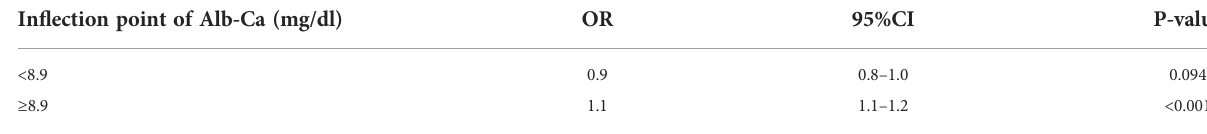
TABLE 1 Threshold effect analysis of albumin-corrected calcium and 30-day in-hospital mortality using piecewise linear regression. In fl ection point of Alb-Ca (mg/dl) OR 95%CI P-value